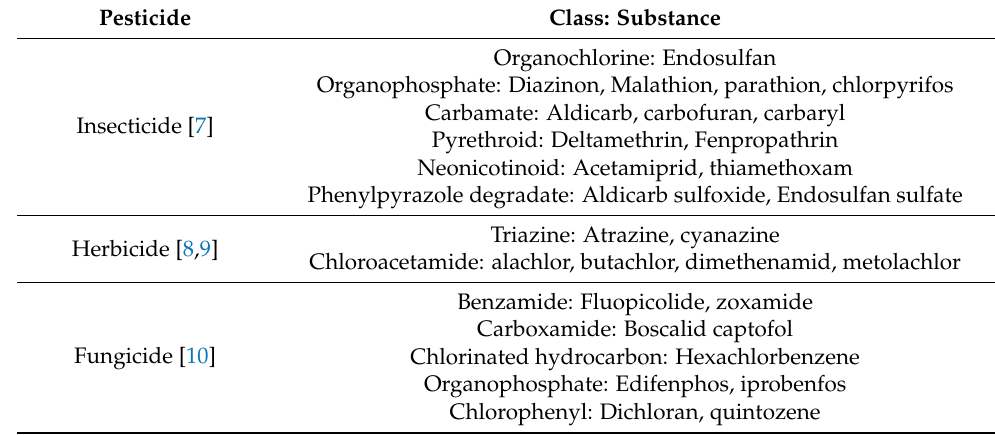
Table 1. Classification of pesticide based on target species.